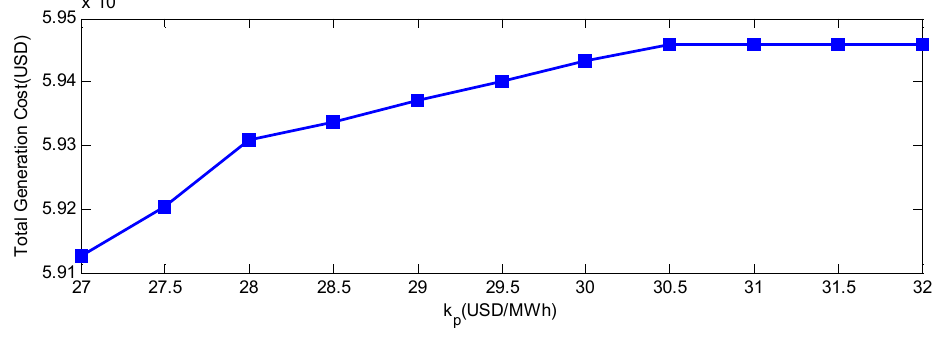
Figure 8. The total generation cost as a function of down reserve cost coefficient.